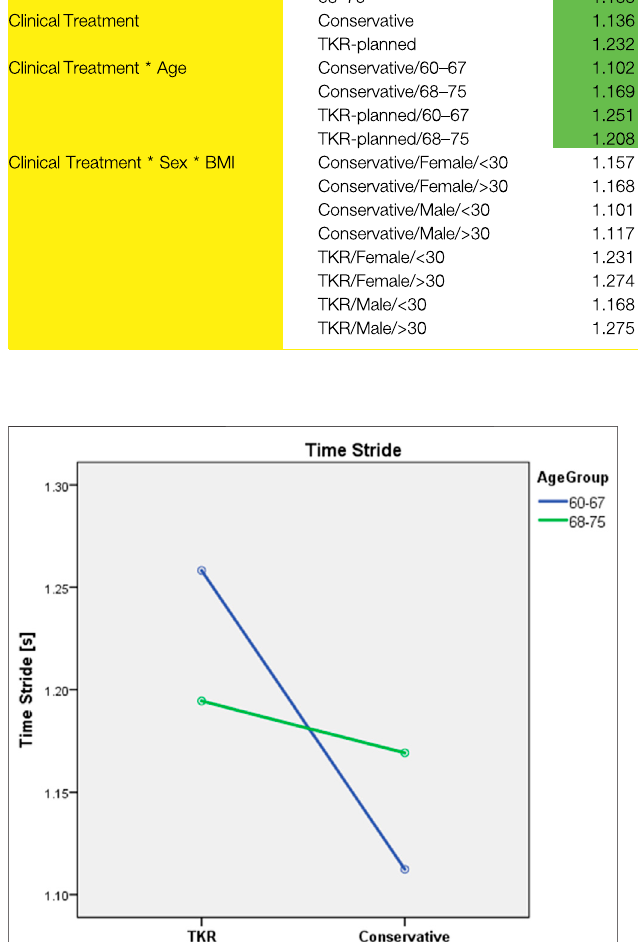
Frontiers in Bioengineering and Biotechnology |